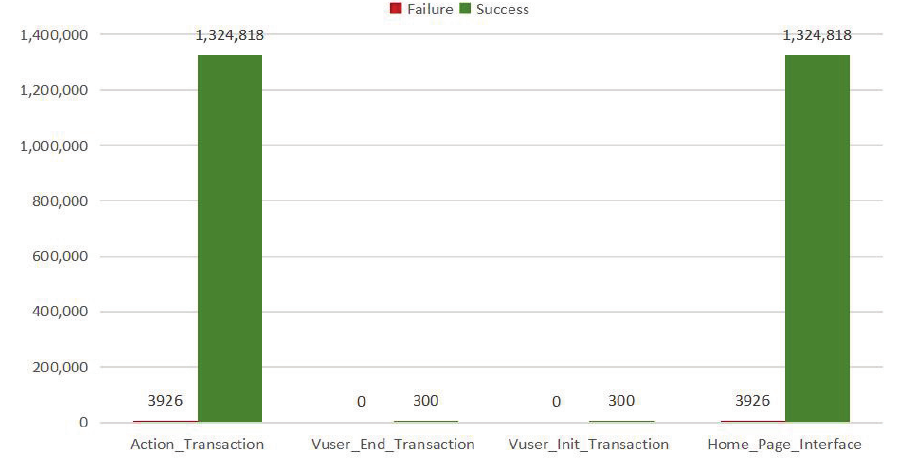
Figure 11. Transaction summary statistical test situation